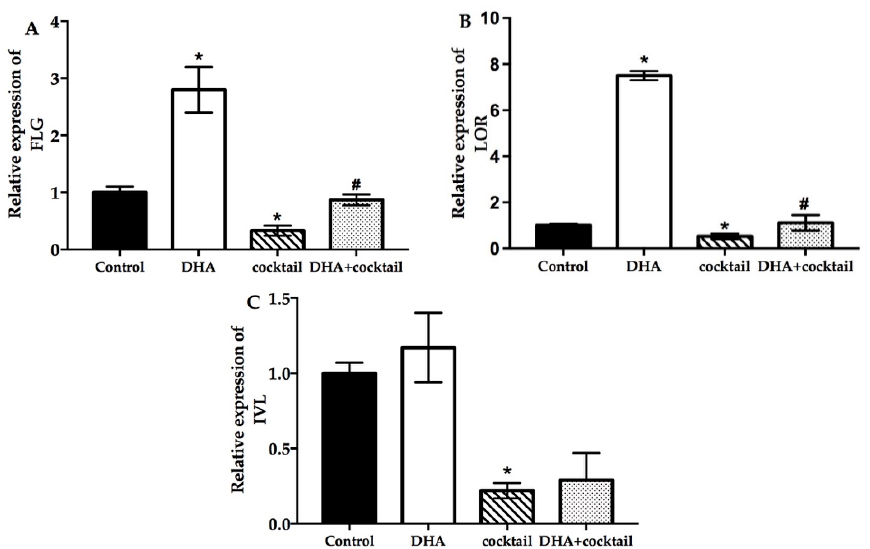
Figure 3. E ff ect of DHA on the di ff erentiation of cultured NHEK cells with or without cocktail (20 µ g / mL LPS plus 10 µ g / mL poly I: C. Real-time quantitative polymerase chain reaction was used to evaluate the changes in FLG ( A ), LOR ( B ), and IVL ( C ) mRNA expression after incubation for 24 h. Data are presented as mean ± SD, n = 5. * Compared with a respective blank group, p < 0.05; # compared with their respective cocktail (20 µ g / mL LPS plus 10 µ g / mL poly I:C)-alone-treated group, p < 0.05.